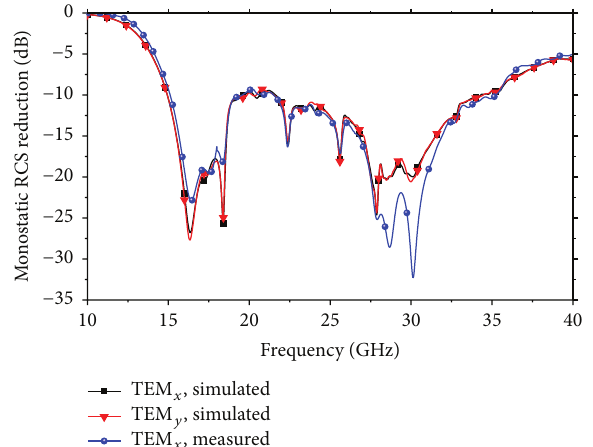
Figure 10: Simulated and measured results of monostatic RCS reduction for optimized phase layout at the normal incidence.